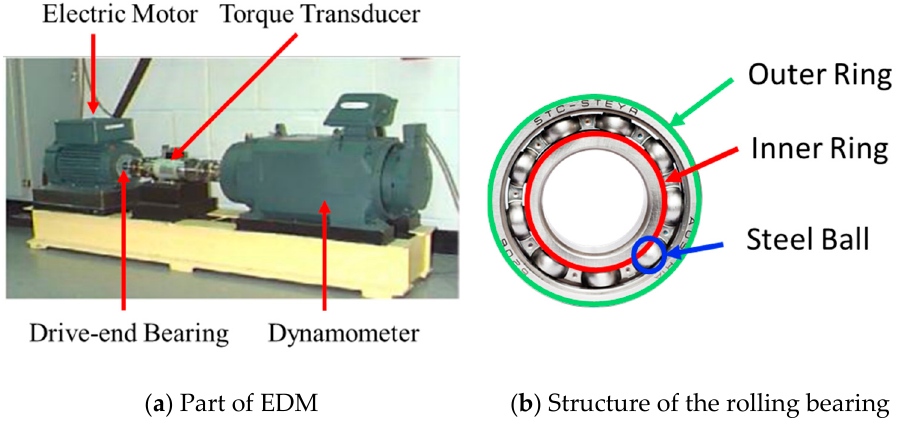
Figure 7. EDM and rolling bearing. Table 1. Status conditions corresponding to different bearing vibration